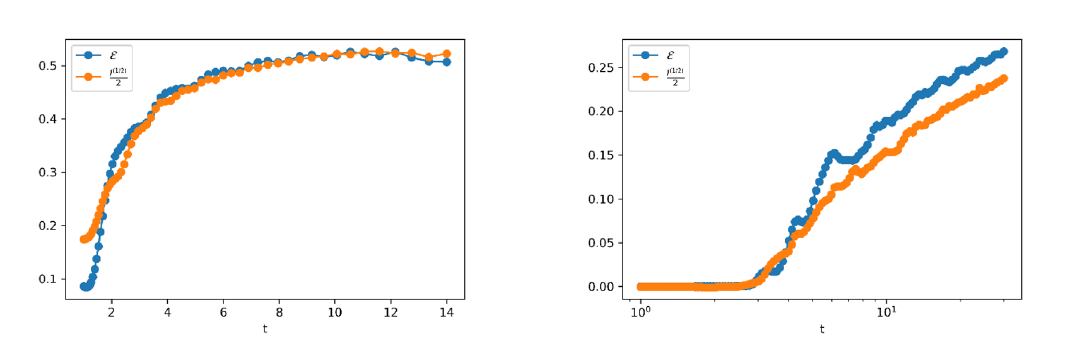
Figure 5 . Left: integrable spin chain. We see a rapid growth to a constant, similar to the behavior for RCFTs, though less sharp due to both finite size effects and a nonlinear dispersion relation. Right: chaotic spin chain. We observe approximately logarithmic growth of the negativity and Rényi mutual information similar to that of pure CFTs. We simulate 31 lattice sites with 5 sites separating “semi-infinite” subsystems. The local operator used is a Pauli Z